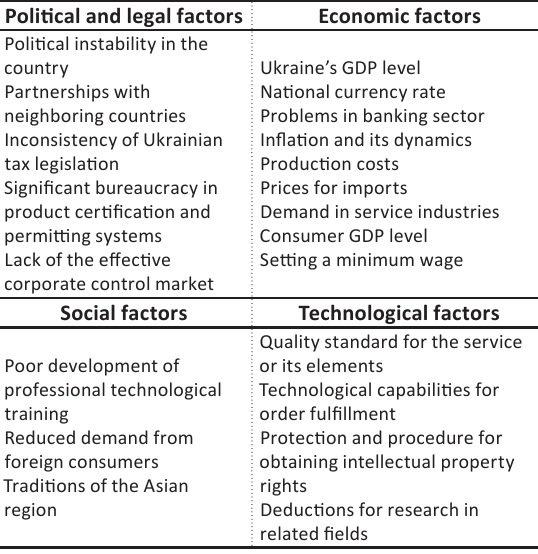
Table 3. PEST analysis matrix for Sigma Software